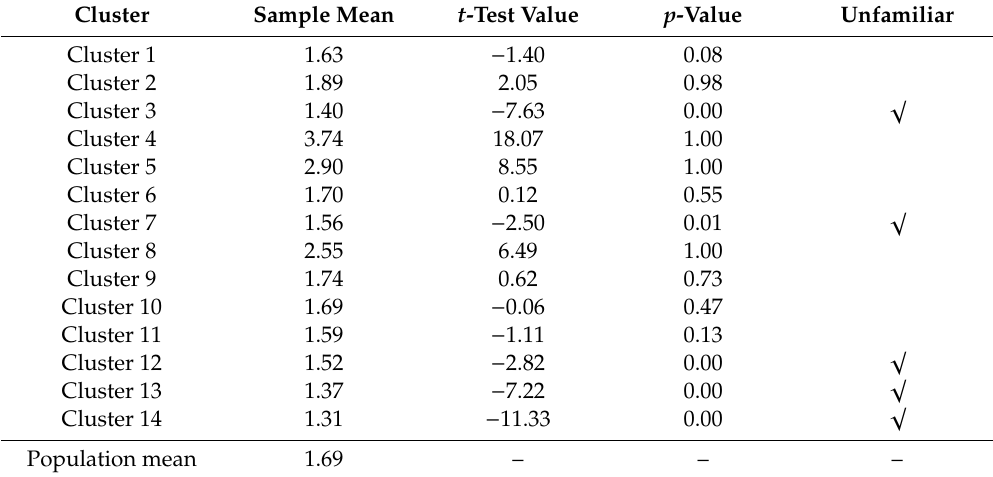
Table 3. Taiwanese unfamiliar city clusters.